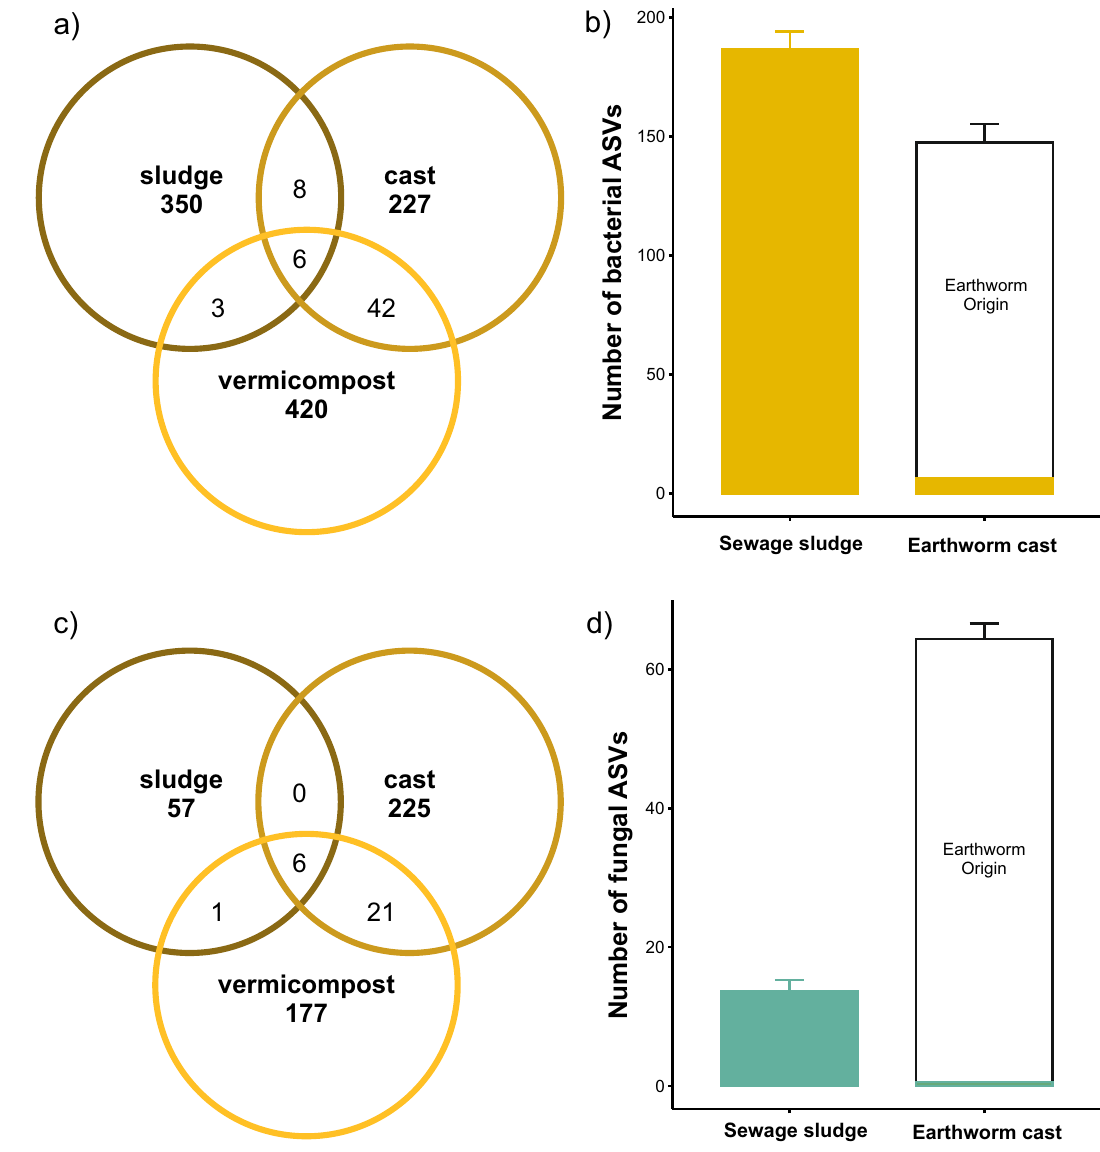
Figure 5. Changes in richness and diversity of bacteria and fungi during vermicomposting of sewage sludge . Venn diagrams showing the absolute number of bacterial ( a ) and fungal ( c ) ASVs found in sewage sludge, fresh earthworms casts and vermicompost (3 months old). Effect of GAP (gut-associated processes) on the richness and diversity of ( b ) bacteria and ( d )